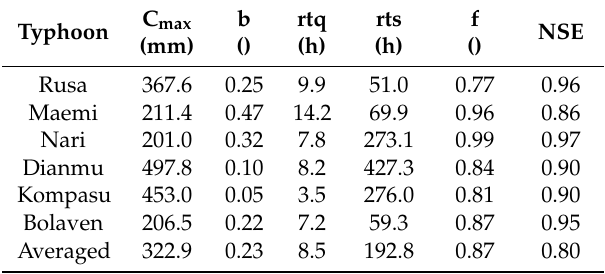
Table 5. Calibrated model parameters for the six typhoon floods at